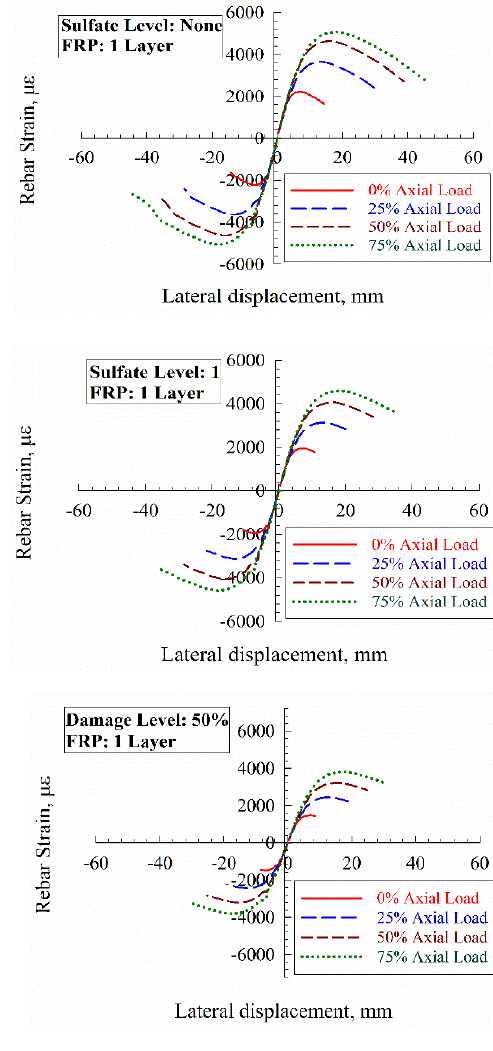
Figure 13. FRP’s strains. 4.4. Displacement Ductility and Energy Dissipation The ratio between the ultimate and yield displacements ( (cid:3031)(cid:3040) (cid:3031)(cid:3052) ) is known as the dis- placement ductility index. Strengthened NLFEA models’ values of displacement ductility are shown in Table 3, from which it can be seen that the displacement ductility of the models was 0, indicating a fragile seismic behavior. This does include the models: J50FRP0D0, J75FRP0D0, and J75FRP0D25. The reason behind this bad behavior is that fail- ures occur before steel yielding is reached. However, the strengthened-with-FRP joint models showed higher values of displacement ductility (twice as much) than the un- strengthened models (i.e., J50FRP0D0, J75FRP0D0, and J75FRP0D25). This was because the strengthened models were perfectly confined with FRP wraps, which made the joints’ failure ductile where a plastic hinge is initiated within the beam element. Moreover, Table 3 shows that there was an enhancement in the displacement ductility due to applying axial load (in comparison with a strengthened joint specimen with 0% axial load) by; 95%, 185%, and 340% corresponding to axial loading levels of 25%, 50%, and 75%, respectively. Further, the ductility is reduced by 45% at 25% and 60% at 50% under the different dam- age levels. Table 3. Various structural characteristics of the simulated joints. Specimen